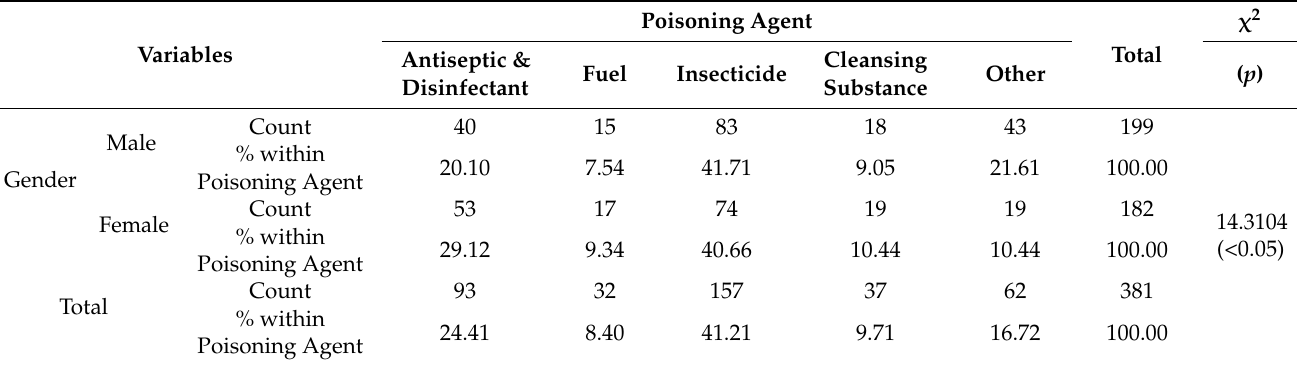
Table 2. Relationship between gender and frequency and type of poison